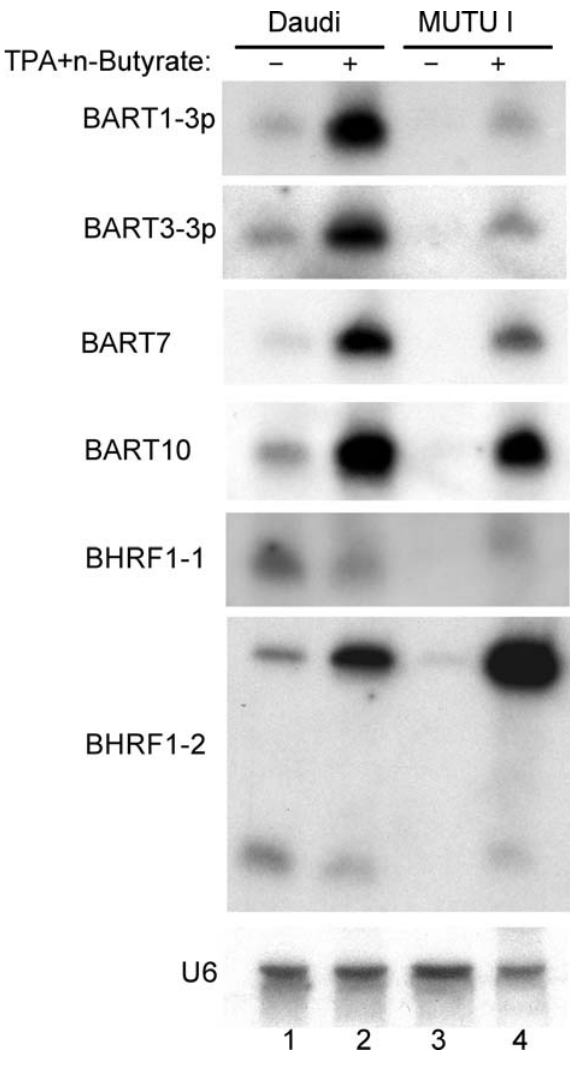
Figure 3. Induction of Lytic Replication Can Increase EBV miRNA Expression The EBV-infected B-cell lines Daudi and MUTU I were either cultured under normal conditions or treated with TPA (30 ng/ml) and n-butyrate (300 ng/ml) for 48 h. At this point cell samples were analyzed for entry into lytic EBV replication by immunofluorescent detection of Zebra expression (see Figure S4) or used for RNA preparation and Northern analysis, as described in Figure 2. In the case of miR-BHRF1–2, we here show a larger panel that also includes the approximately 59-nt pre- miRNA precursor, as this was more readily detected than the mature approximately 23-nt miR-BHRF1–2 miRNA. DOI: